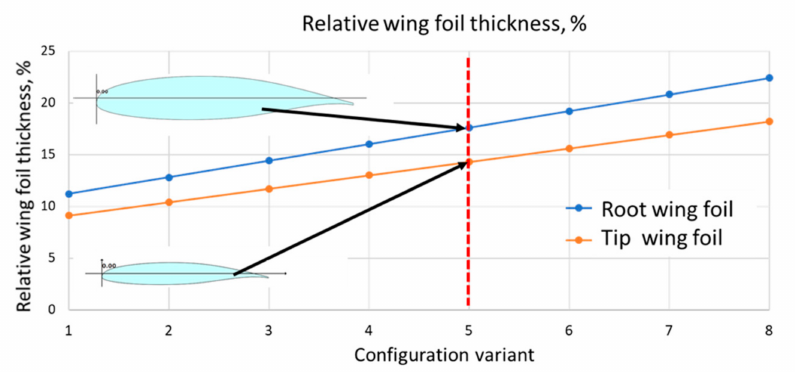
Figure 11. Variation of root and tip foils of the